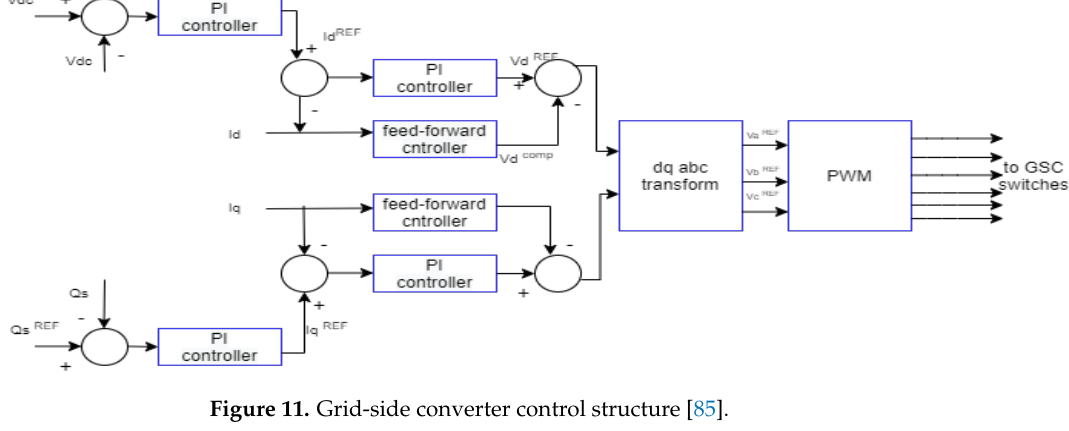
Figure 11. Grid-side converter control structure [86].